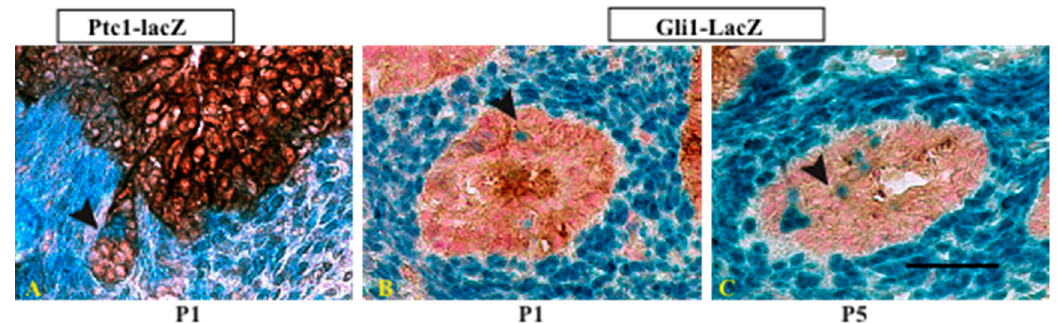
Figure 2. X-gal/PanCK staining of P1/P5 prostate from Gli1 lacZ and Ptc1 lacZ mice showed strong positive beta-gal activity (blue) in the mesenchyme generally and in a limited number of epithelial cells (brown) in the nascent ducts (arrowheads). N = 3, scale bar = 40 µm